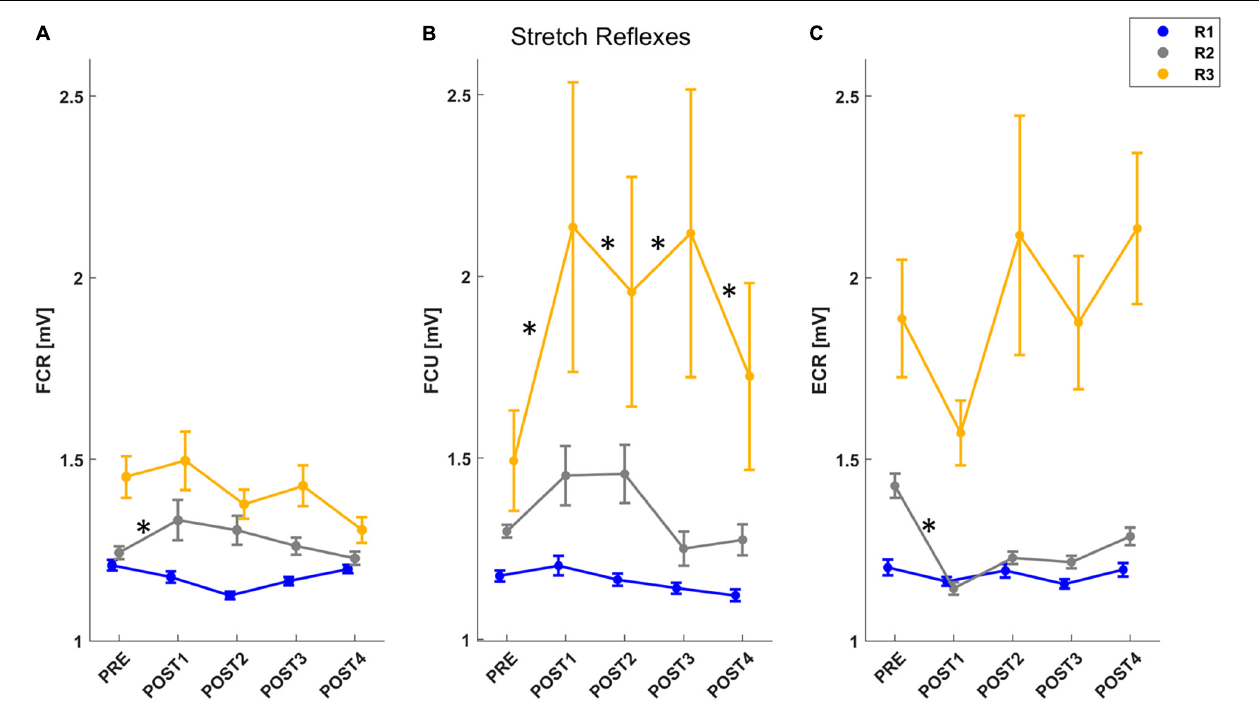
FIGURE 5 | The mean and standard error of muscle activity for each muscle stretched by the perturbation: FCR (A) , FCU (B) , ECR (C) . For each figure, muscle activity is reported for R1 (short-latency reflex): 20–45 ms (blue line), R2 (mid-latency reflex): 45–75 ms (gray line), R3 (long-latency reflex): 75–105 ms (yellow line). After post-hoc analysis, significant differences ( p < 0.05) in muscle activity for each temporal epoch compared with PRE assessment were marked with “ ∗ ”.